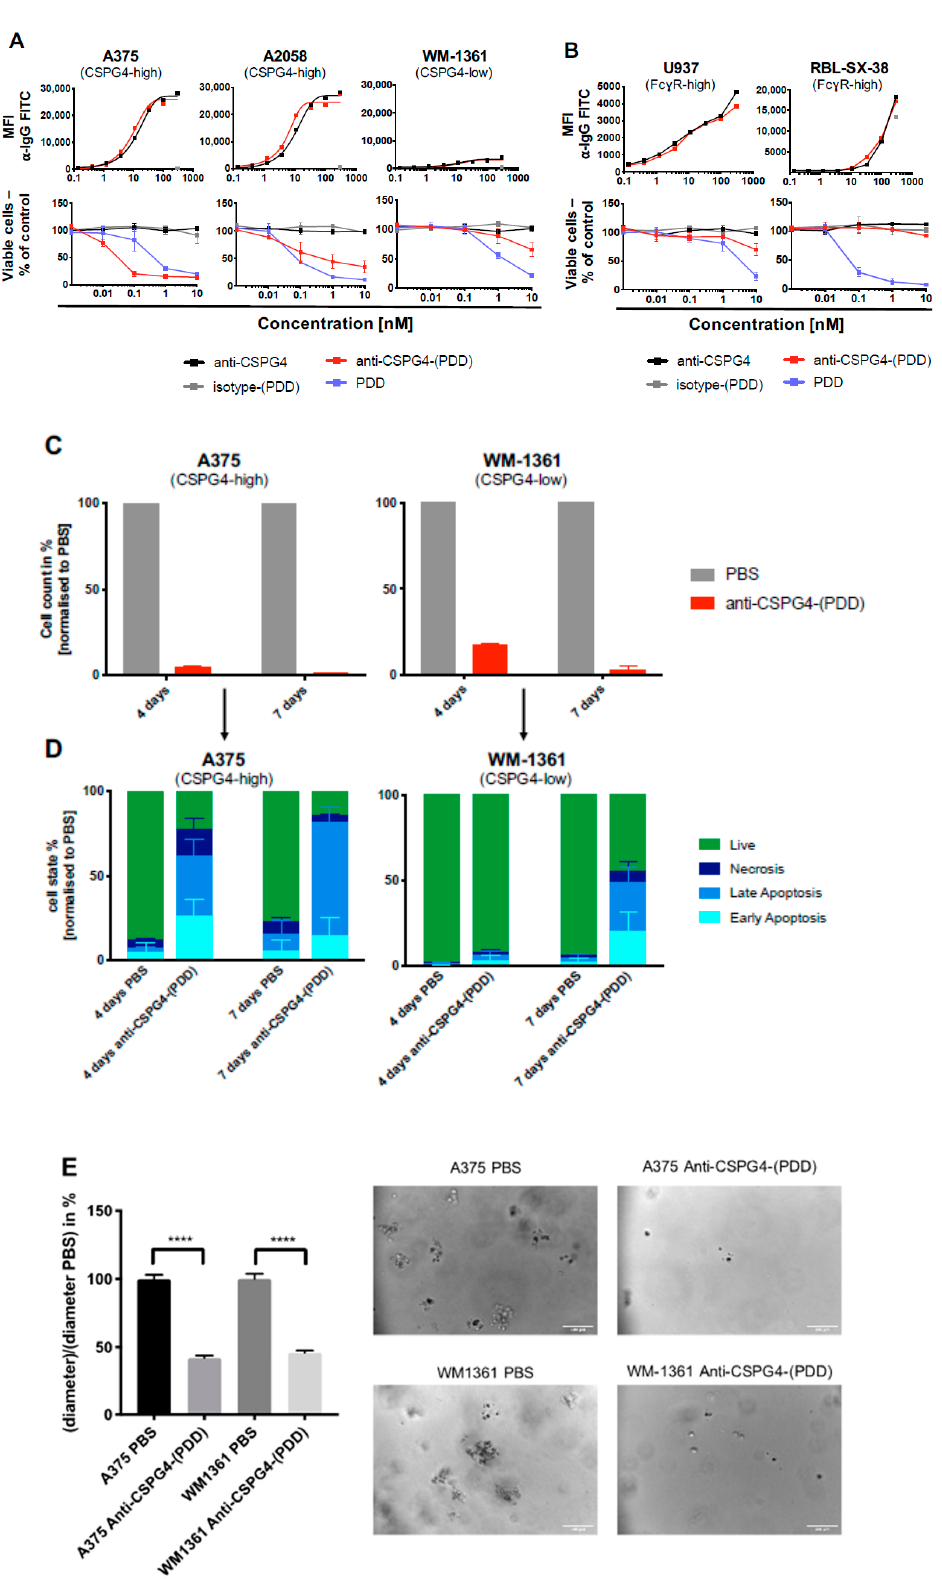
Figure 5. Anti-CSPG4-(PDD) promotes target selective melanoma cell killing and tumor cell apoptosis with no toxicity to immune cell lines. ( A ) Binding of anti-CSPG4 and anti-CSPG4-(PDD) to CSPG4-high and CSPG4-low melanoma cell lines (top panel). Investigation of cell viability of melanoma cell